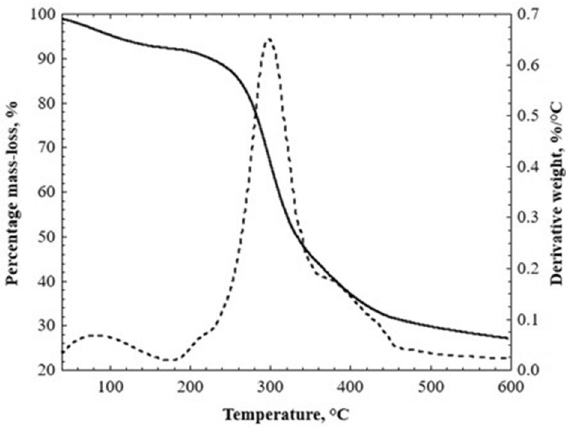
Figure 1. TGA thermogram for devilfish